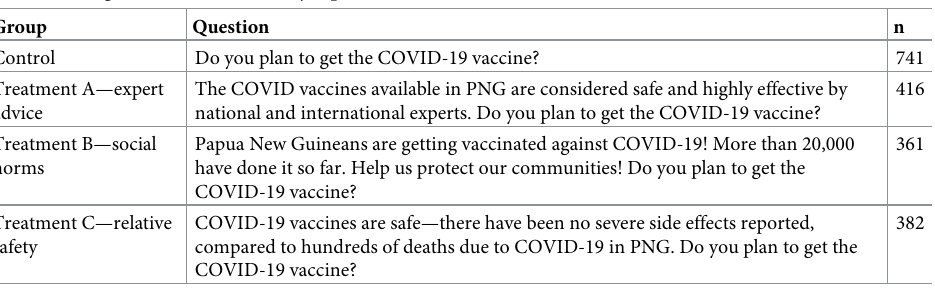
Table 1. Design of randomized survey